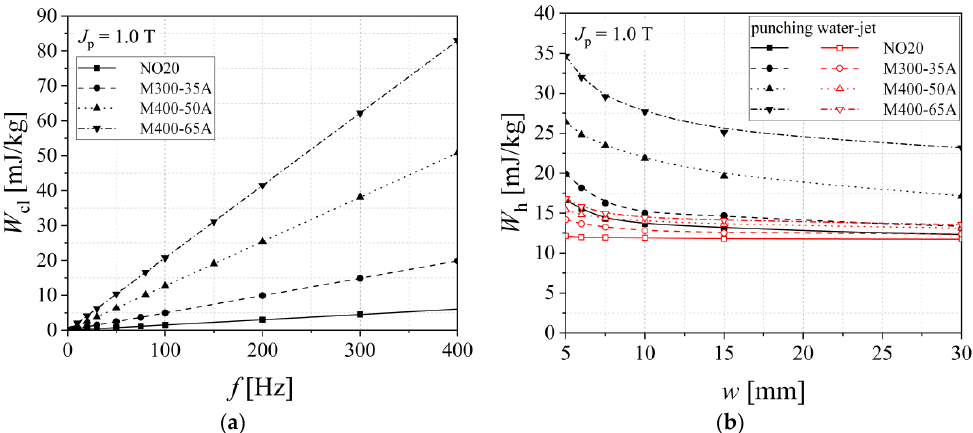
Figure 13. Classical ( a ) and hysteresis energy loss ( b ), in the case of two cutting technologies.